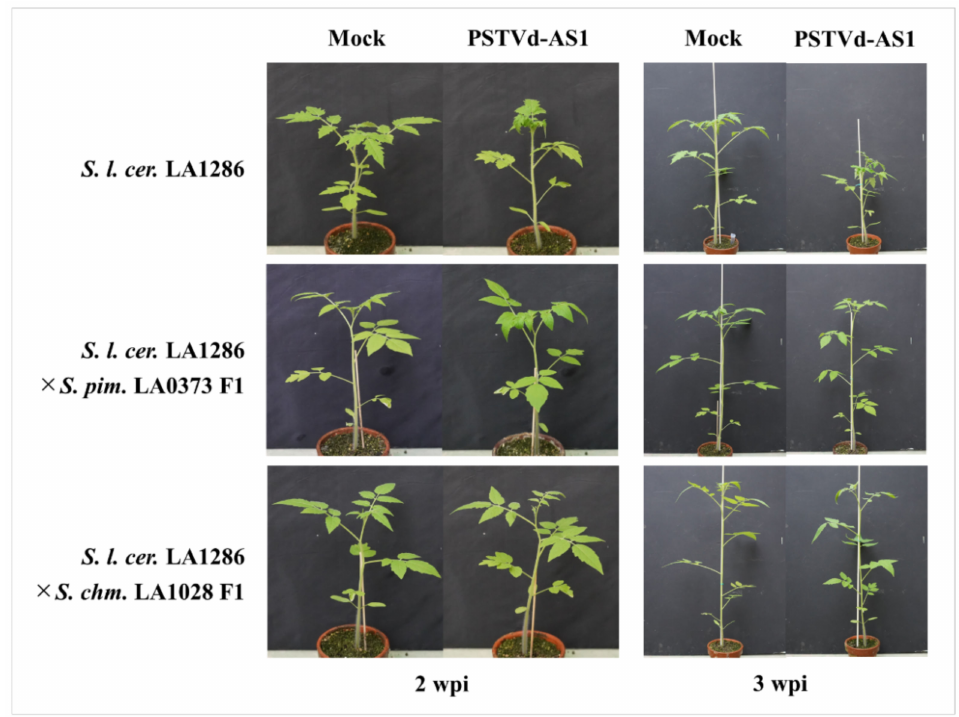
Figure 7. F1 hybrids between a PSTVd-sensitive wild tomato and PSTVd-tolerant wild relatives were tolerant to PSTVd. At 2 weeks post-inoculation (wpi), S. l. cerasiforme LA1286 showed severe leaf curling, whereas S. l. cerasiforme LA1286 × S. pimpinellifolium LA0373 F1 or S. l. cerasiforme LA1286 × S. chmielewskii LA1028 F1 showed very mild leaf curling or was asymptomatic. At 3 wpi, S. l. cerasiforme LA1286 exhibited stunting and vein necrosis, whereas S. l. cerasiforme LA1286 × S. pimpinellifolium LA0373 F1 recovered from mild symptoms and both F1 hybrids were asymptomatic even after lethal PSTVd-AS1 infection.